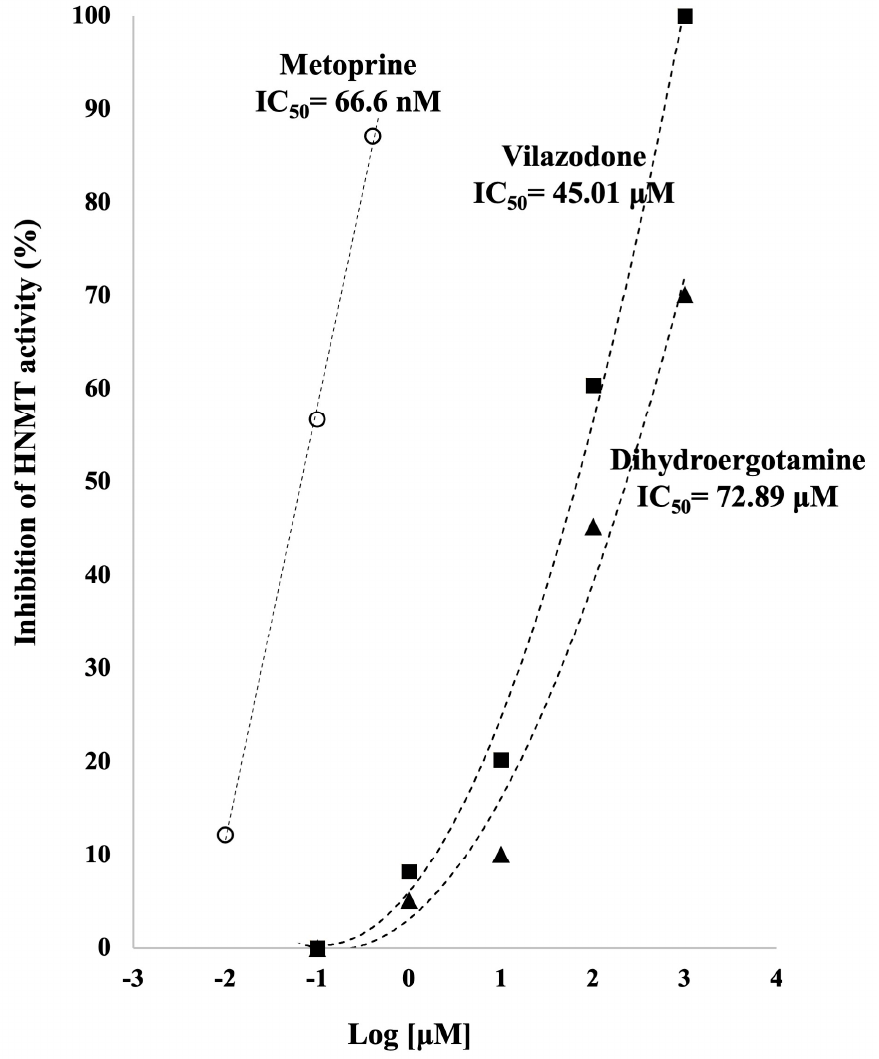
Figure 6. Quantitative HNMT inhibition by metoprine (66.6 nM), dihydroergotamine (72.89 µ M) and vilazodone (45.01 µ M). These results demonstrate that vilazodone and dihydroergotamine are inhibitors of HNMT. The activity of HNMT in the absence of compounds was considered 100% of activity. Values on the graph represent the mean values. The concentration–response curve was obtained and the IC 50 values were estimated for all compounds through linear regression analysis.